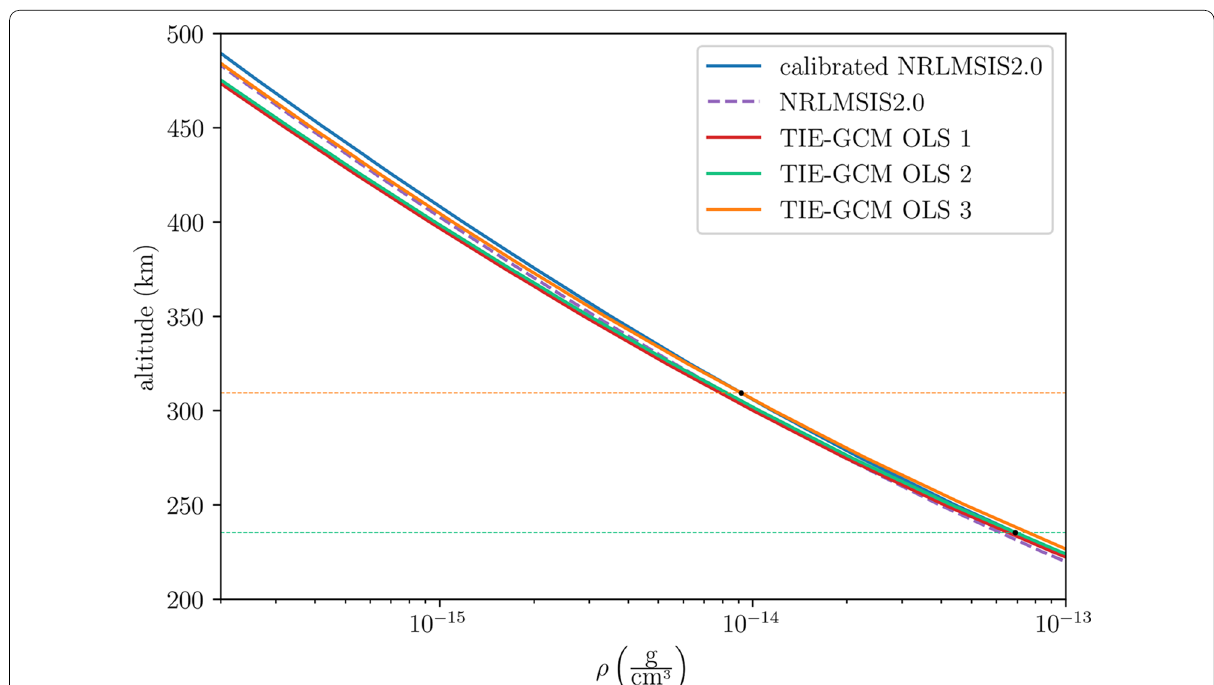
Fig. 5 For each altitude of the data grid we computed the median of the neutral mass density including all longitudes, latitudes and times. The horizontal dotted lines indicate the intersection of the height profile of the calibrated NRLMSIS 2.0 with the profile of the corresponding open-loop simulation. Below 350 km the lines do not intersect